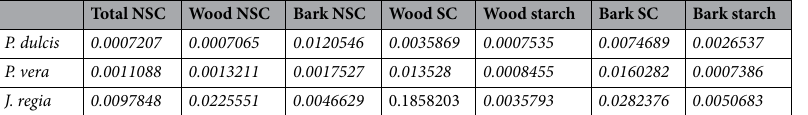
Table 3. Kruskall Wallis test for seasonality in a time series with lag time of 12 months. Italics denote p < 0.05—significant